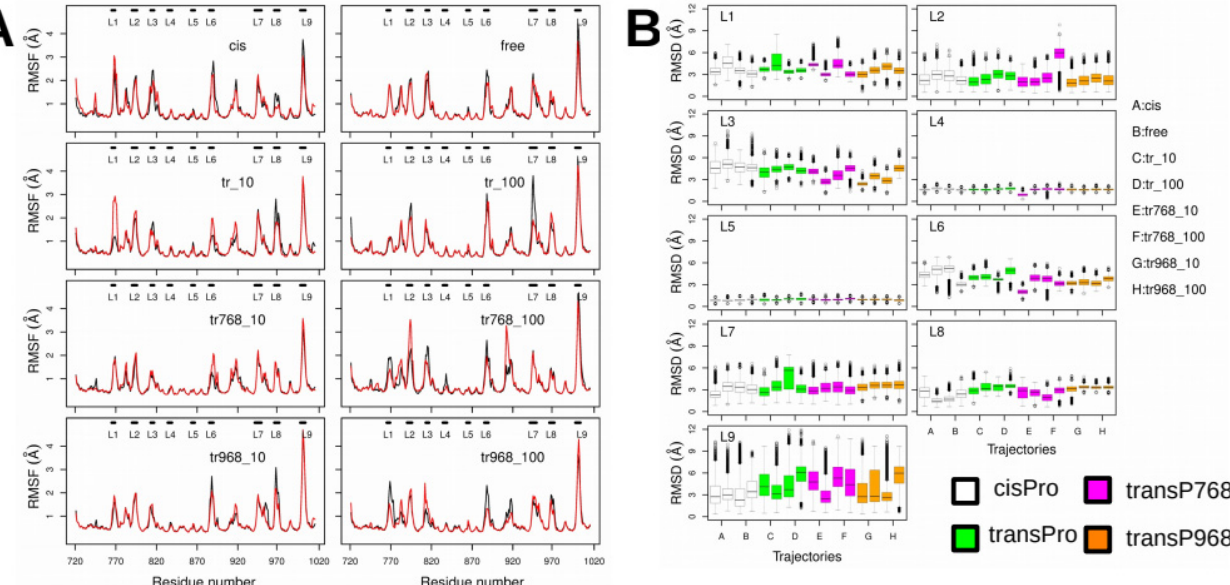
Figure 3. Refined analysis of X-Pro imide bond cis-trans isomerization on the internal dynamics of the upper loops. ( A ) Coordinate RMSFs (Å) of the backbone heavy atoms. For each trajectory, the black and red curves correspond to the replicas R1 and R2. ( B ) Distribution of coordinate RMSDs (Å) of the backbone heavy atoms calculated for loops L1 (residues 764–768), L2 (residues 789–795), L3 (residues 812–816), L4 (residues 833–838), L5 (residues 862–866), L6 (residues 884–889), L7 (residues 940–948), L8 (residues 964–970) and L9 (residues 996–1002). Before the RMSDs were calculated, the entire CNF1 structure was first superimposed on the structure taken from PDB entry 1HQ0. The RMSD distributions are plotted as box plots colored white (trajectories cis, free), green (trajectories tr_10, tr_100), magenta (trajectories tr768_10, tr768_100), and orange (trajectories tr968_10, tr968_100). For each trajectory, the distributions of the two replicas are drawn.